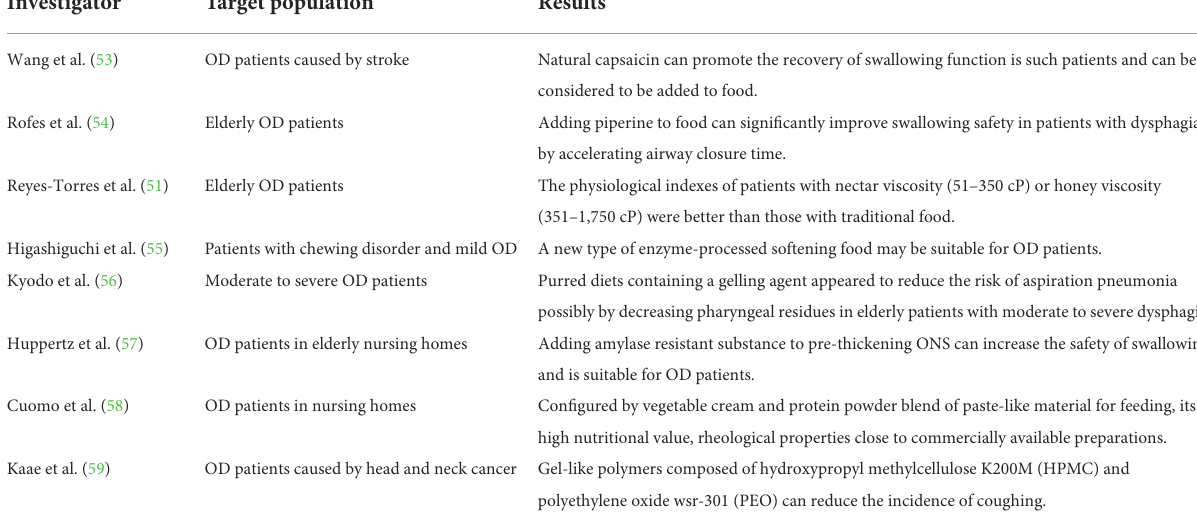
TABLE 2 Summary of food products suitable for OD patients.